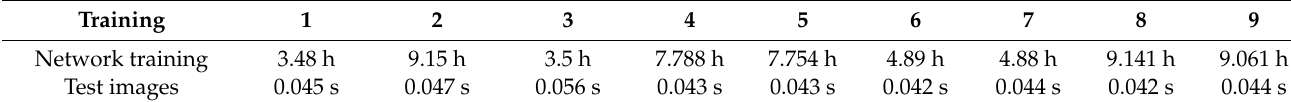
Table 5. Average network training time for each training and test image.